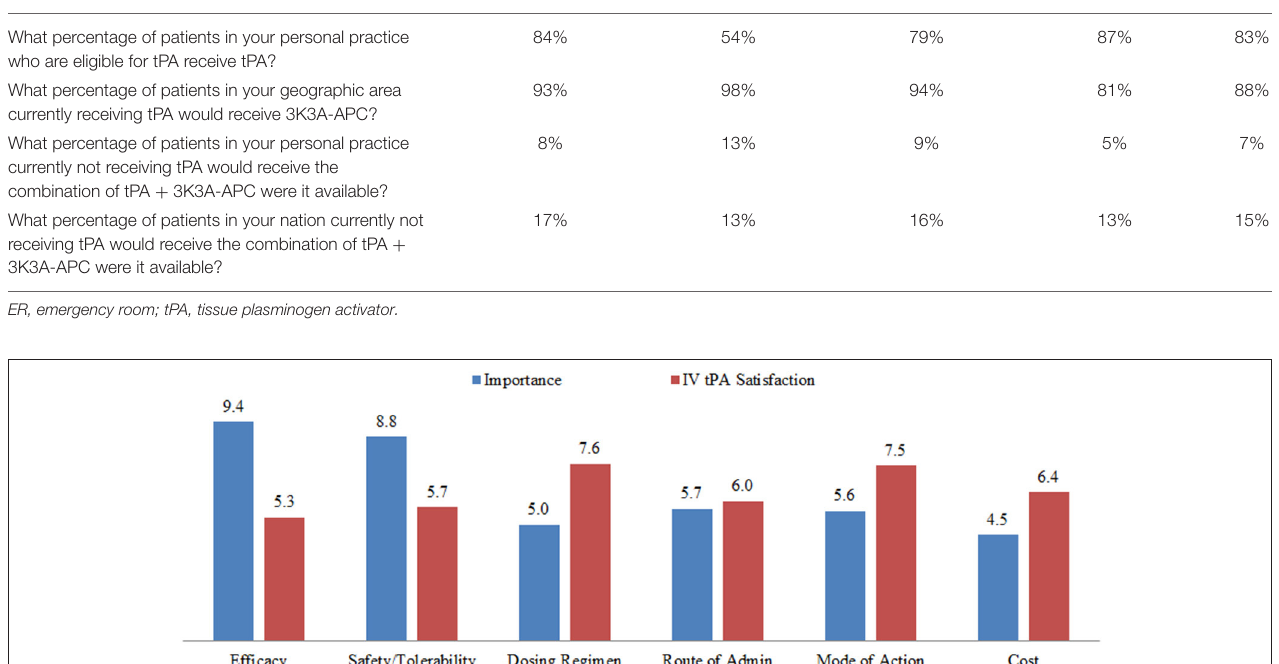
TABLE 4 | Market research survey data from stroke specialists about stroke therapies. Question